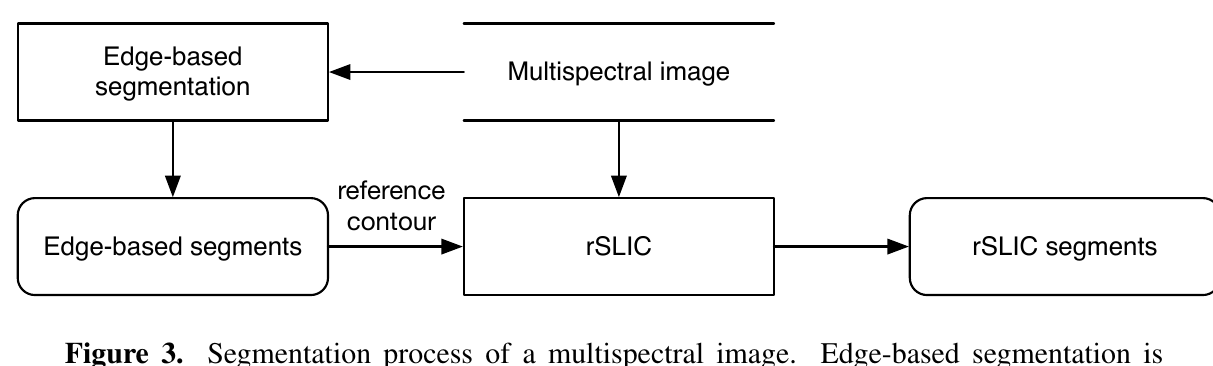
Figure 3. Segmentation process of a multispectral image. Edge-based segmentation is applied to obtain an initial segmented image. These segments are later used as reference contour by rSLIC to generate